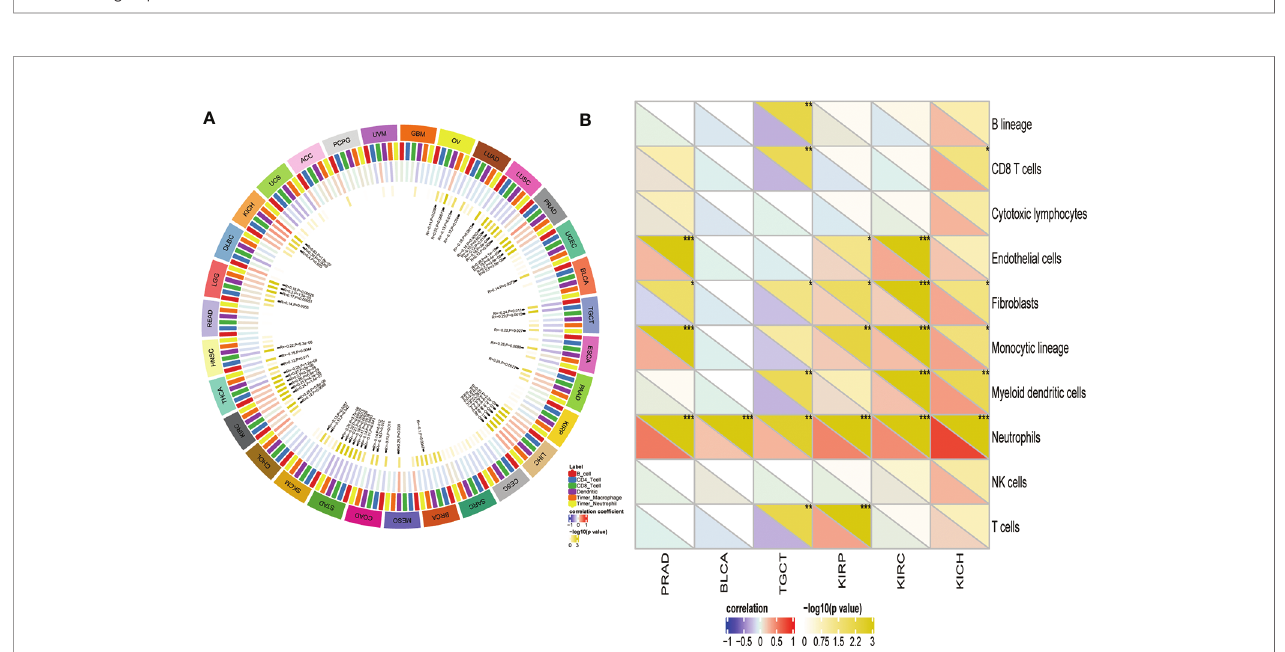
FIGURE 7 | The relationship between YTHDF1 expression and in fi ltrating immune cells of human cancers and urogenital cancers. (A) the relationship between YTHDF1 expression level and in fi ltrating levels of B cells, CD4+ T cells, CB8+ T cells, macrophages, neutrophils, dendritic cell in human cancers. (B) the relationship between YTHDF1 expression level and in fi ltrating levels of B cell lineages, CB8+ T cells, cytotoxic lymphocytes, endothelial cells, fi broblasts, monocytic cell lineages, myeloid dendritic cells, neutrophils, natural killer cells, T cells in six urogenital cancers. * P < 0.05; ** P < 0.01; *** P <